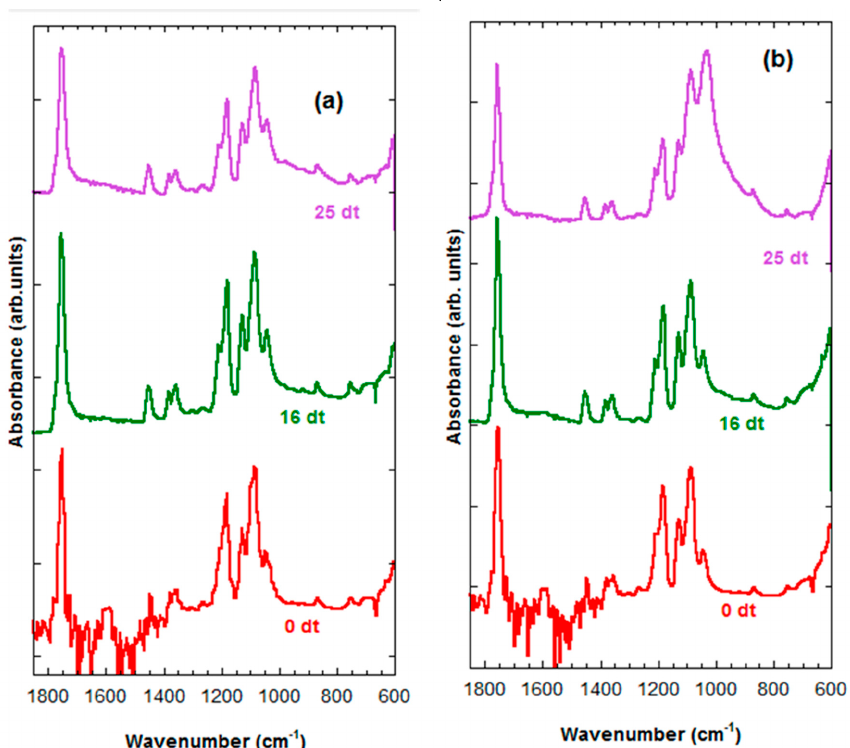
Figure 7. FTIR spectra. ( a ) PLLA-30%nFe 3 O 4 after various degradation times (0, 16 and 25 weeks), ( b ) PLLA-70%nFe 3 O 4 after various degradation times (0, 16 and 25 weeks).